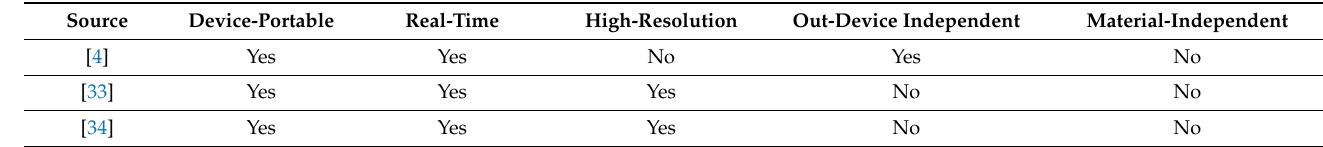
Table 5. Future trend from related